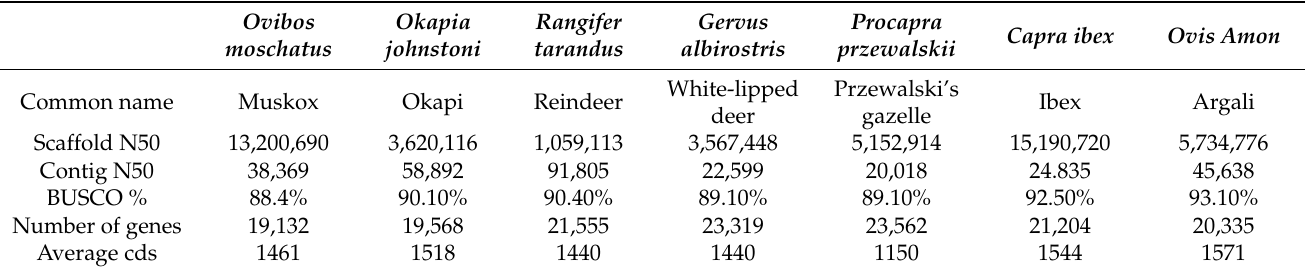
Table 2. Comparison of the final muskox genome assembly to both another Arctic ruminant (reindeer) and the highest quality wild ruminant genomes assembled by Chen et al. [45].